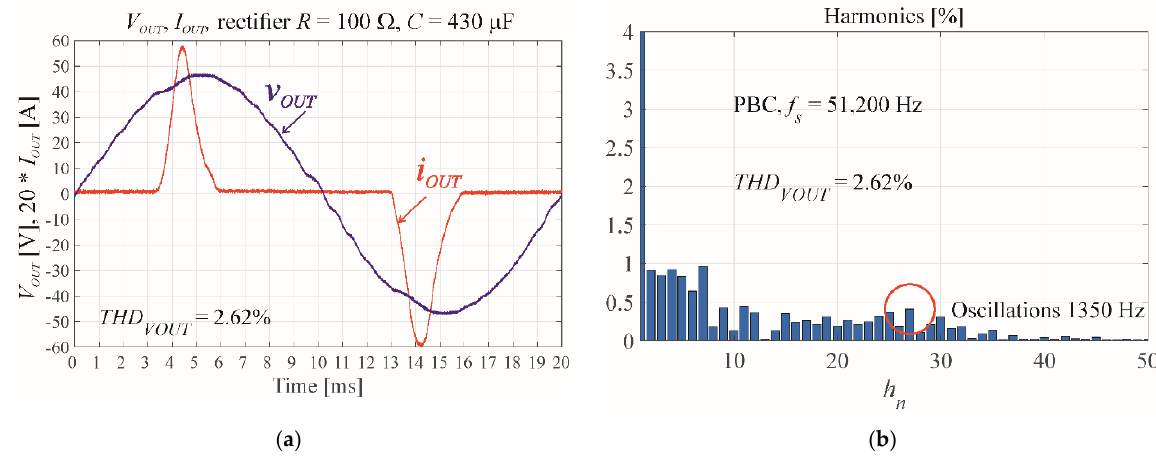
Figure 14. ( a ) The output voltage and current; ( b ) The harmonics analysis of the output voltage for the PBC with gain values that exceeded the experimentally adjusted border gains ( R i = 3, K v = 0.7, R i ’ = 10.98, K v ’ = 2.56) for f s = 51,200 Hz (RC load: R = 100 Ω , C = 430 μ F).